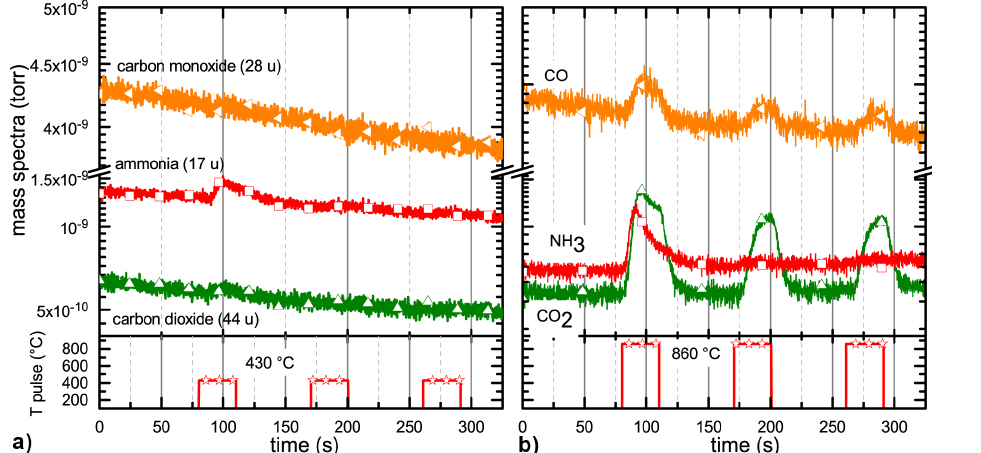
Figure 6. Mass spectra of ammonia-contaminated fly ash (84mgkg − 1 ) when heating up the ash to 430 ◦ C (a) and 860 ◦ C (b) . Carrier gas is